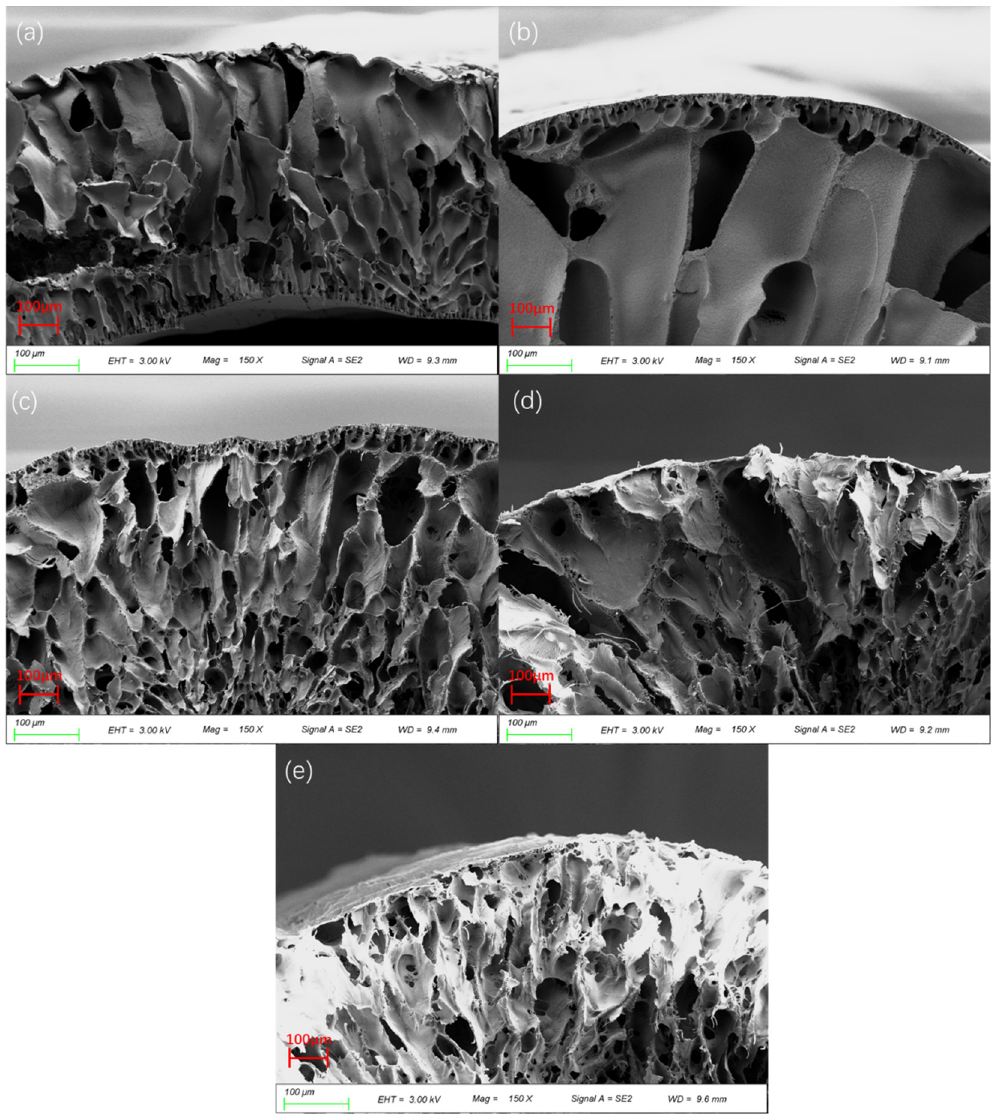
Figure 6. SEM cross-sectional morphologies of PVDF/PEI blend membrane. ( a ) PI0. ( b ) PI1. ( c ) PI2. ( d ) PI3. ( e ) PI4.